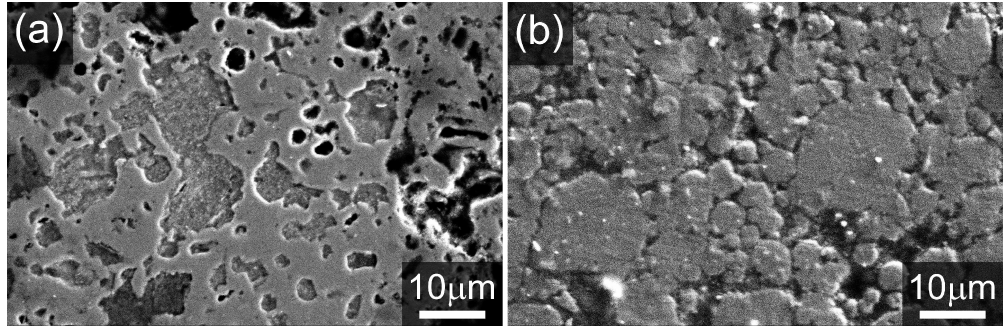
Figure 5. SEM micrographs of the cold-sintered porous Zn electrodes after ( a ) full discharge and ( b ) 152 h of cycling ending on a charge.